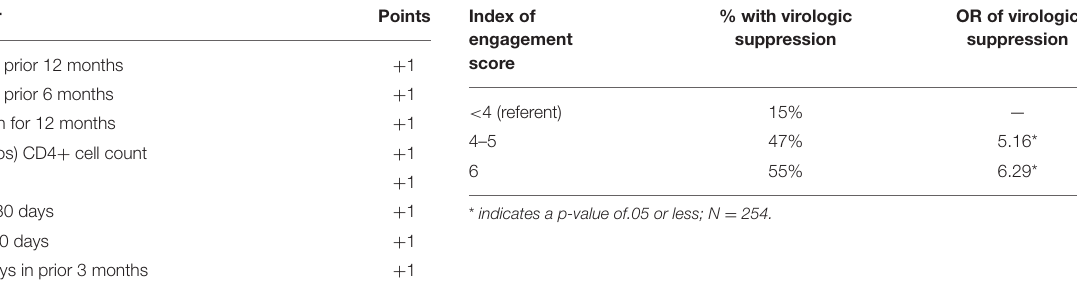
TABLE 3 | Behavioral composite of engagement in HIV care scoring. Engagement indicator Points